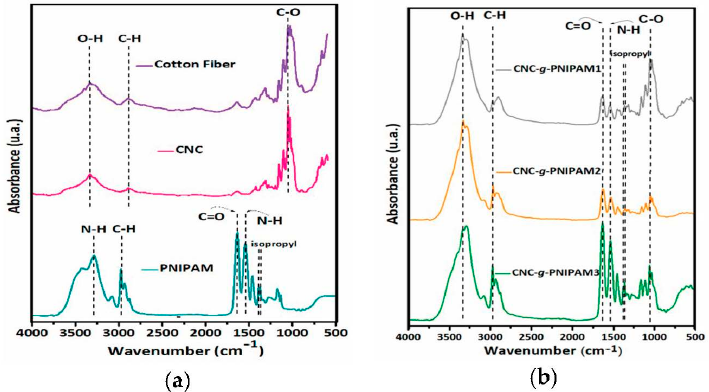
Figure 1. Infrared spectra of ( a ) cotton fibers, CNCs, and PNIPAM; ( b ) CNC- g -PNIPAM1, CNC- g - PNIPAM2, and CNC- g -PNIPAM3.